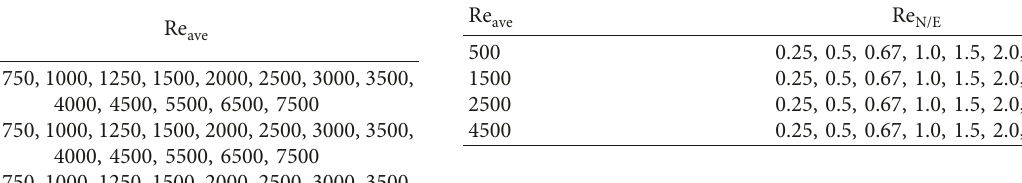
Figure 2: Flow velocity vectors and contours map for cross junction. Contours and arrows indicate the normalized flow velocity and direction. Table 1: Summary of the experimental cases at cross junctions with � 1 and Re � 1. Re W/S N/E